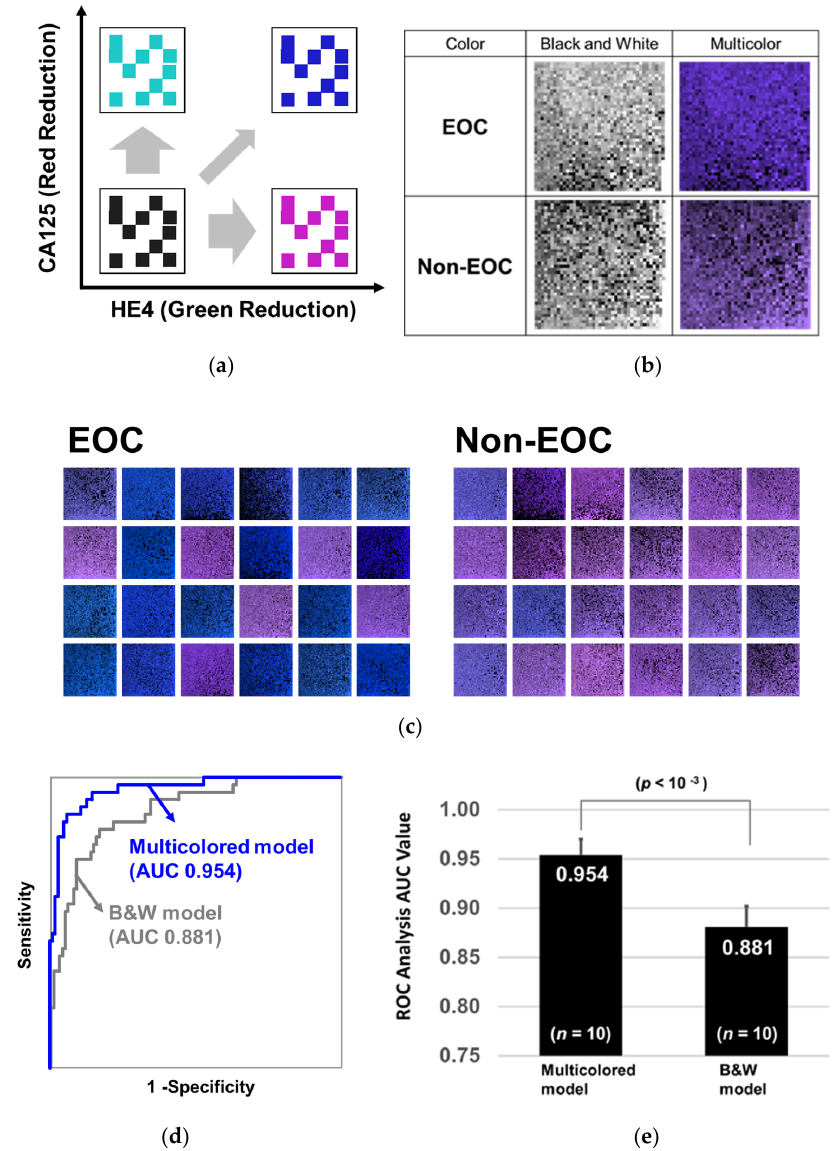
Figure 3. Coloring barcodes on the basis of serum levels of CA125 and HE4. ( a ) The non-multicolored barcodes were colored on the basis of the serum levels of CA125 and HE4. When the level of CA125 increases, the level of red in the barcode decreases, and when the level of HE4 increases, the level of green decreases. ( b ) Comparison of patients with EOC and those with non-EOC before and after the coloring of 2D-barcode images. ( c ) Typical 2D-barcode images of patients with EOC (left) and of those with non-EOC (right). ( d ) After the two models were trained with 60% of the 351 barcodes, they were evaluated by the residual 40% samples. The ROC curves are shown with a blue line (Multicolor) or with a gray line (Black and white). ( e ) This process was repeated 10 times and the p -values of the Wilcoxon rank sum test were calculated between the two groups.